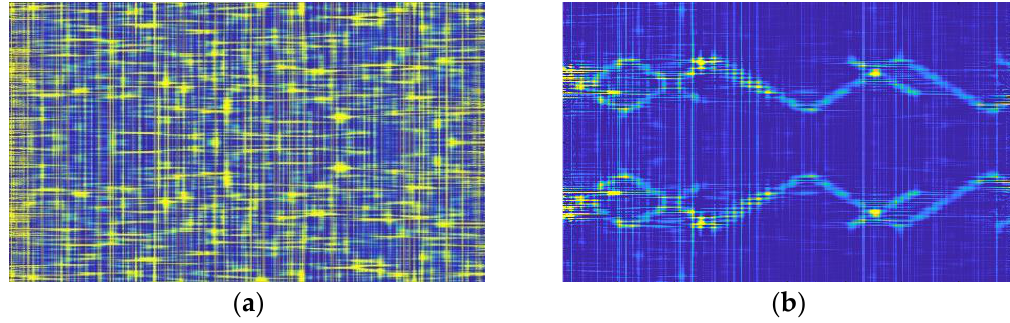
Figure 6. ( a ) unsuppressed noise (−20 dB), ( b ) suppressed noise.